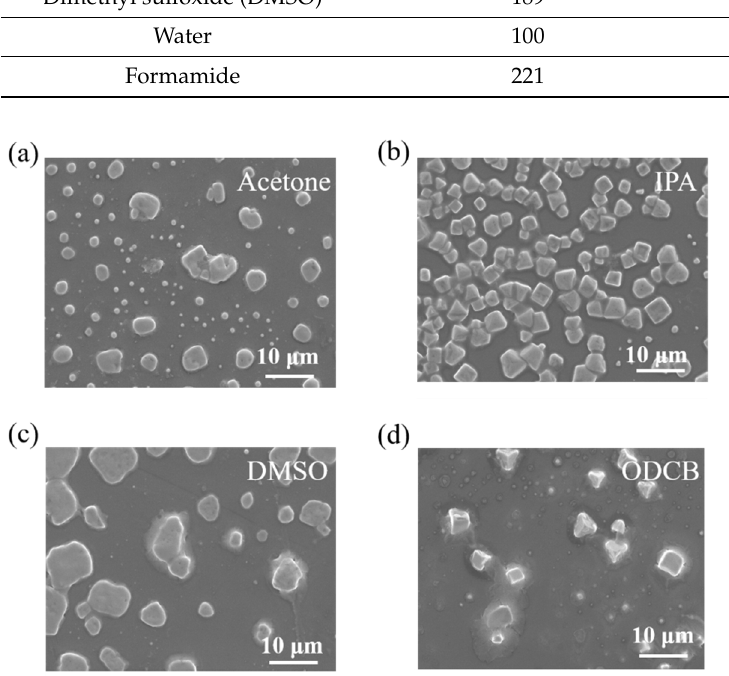
Figure 1. The surface morphology of 3D perovskite fabricated by a co-solvent system using ( a ) acetone, ( b ) IPA, ( c ) DMSO, and ( d ) ODCB as the second solvent.